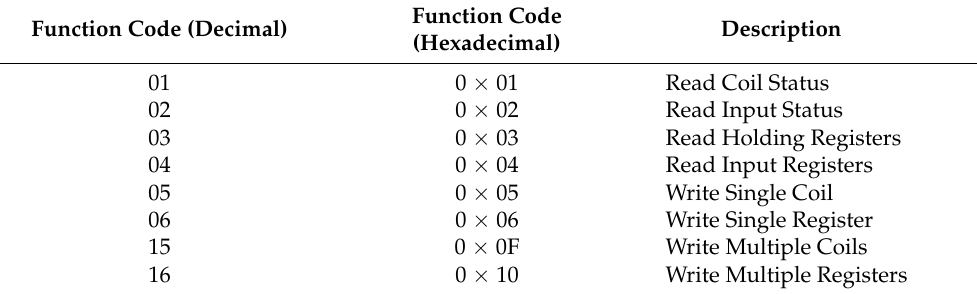
Table 2. Common Modbus function codes.